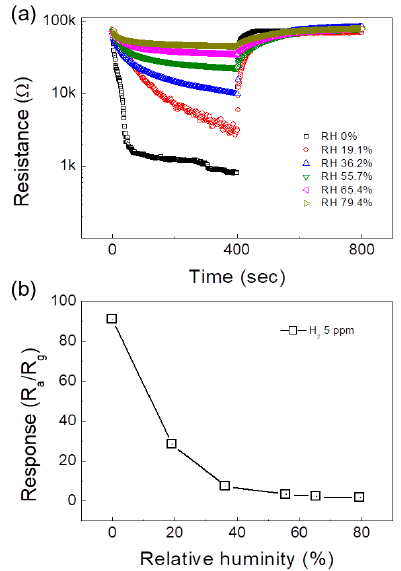
Figure 8. ( a ) Dynamic resistance curves of the 0.1 SnO 2 ‐ loaded ZnO NF gas sensor to 5 ppm H 2 gas in the presence of 0–79.4% relative humidity (RH). ( b ) Response to 5 ppm H 2 versus RH%.